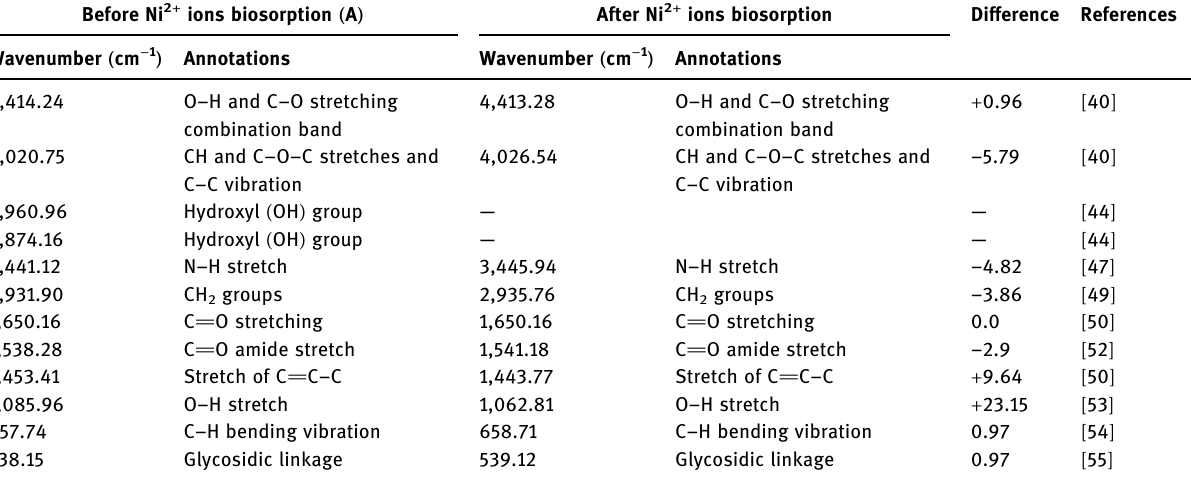
Table 6: Analysis of FTIR spectrum results of Gelidium amansii biomass before and after Ni 2 + ion biosorption from aqueous solution Before Ni 2 + ions biosorption ( A